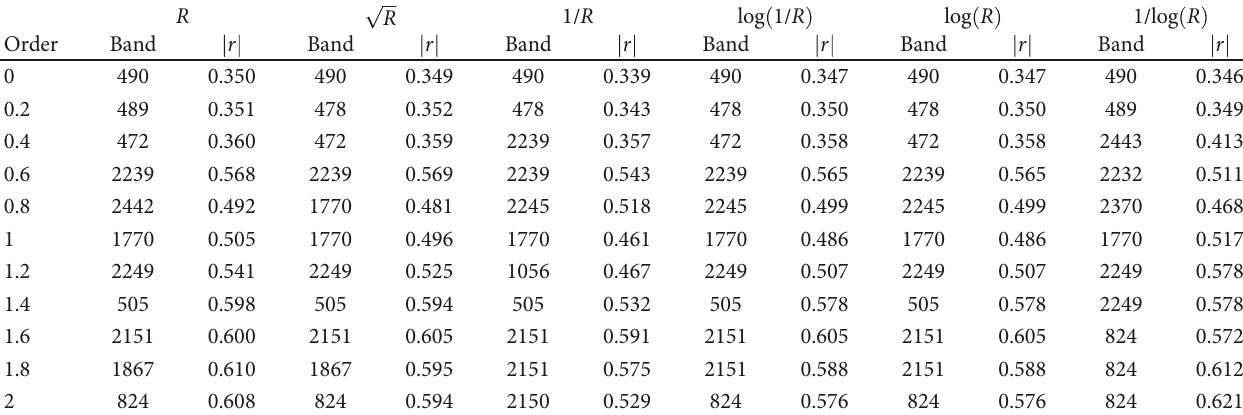
Table 3: The bands corresponding to the maximum of the absolute value of the correlation coe ffi cient of each transform. R R 1/ R log 1/ R log